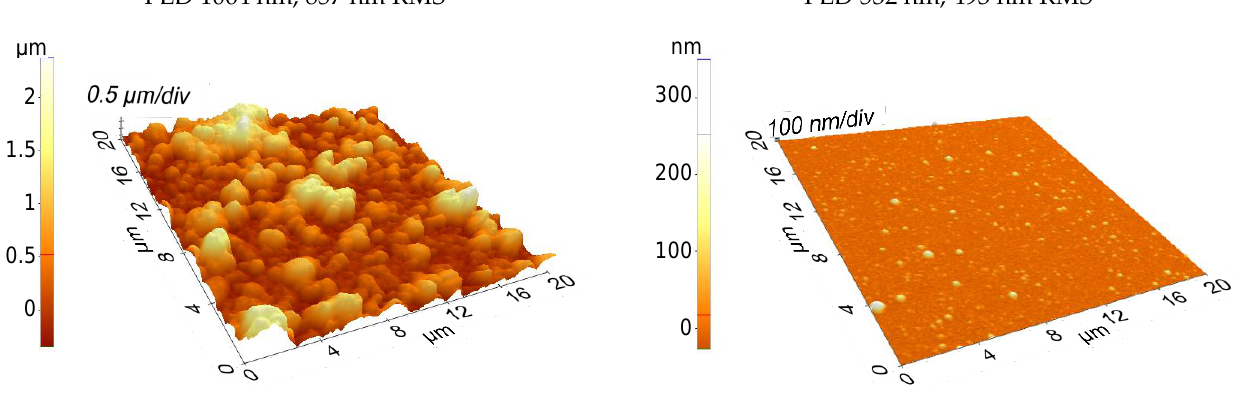
Figure 7. RMS roughness and thickness of films deposited by MAPLE and PLD.